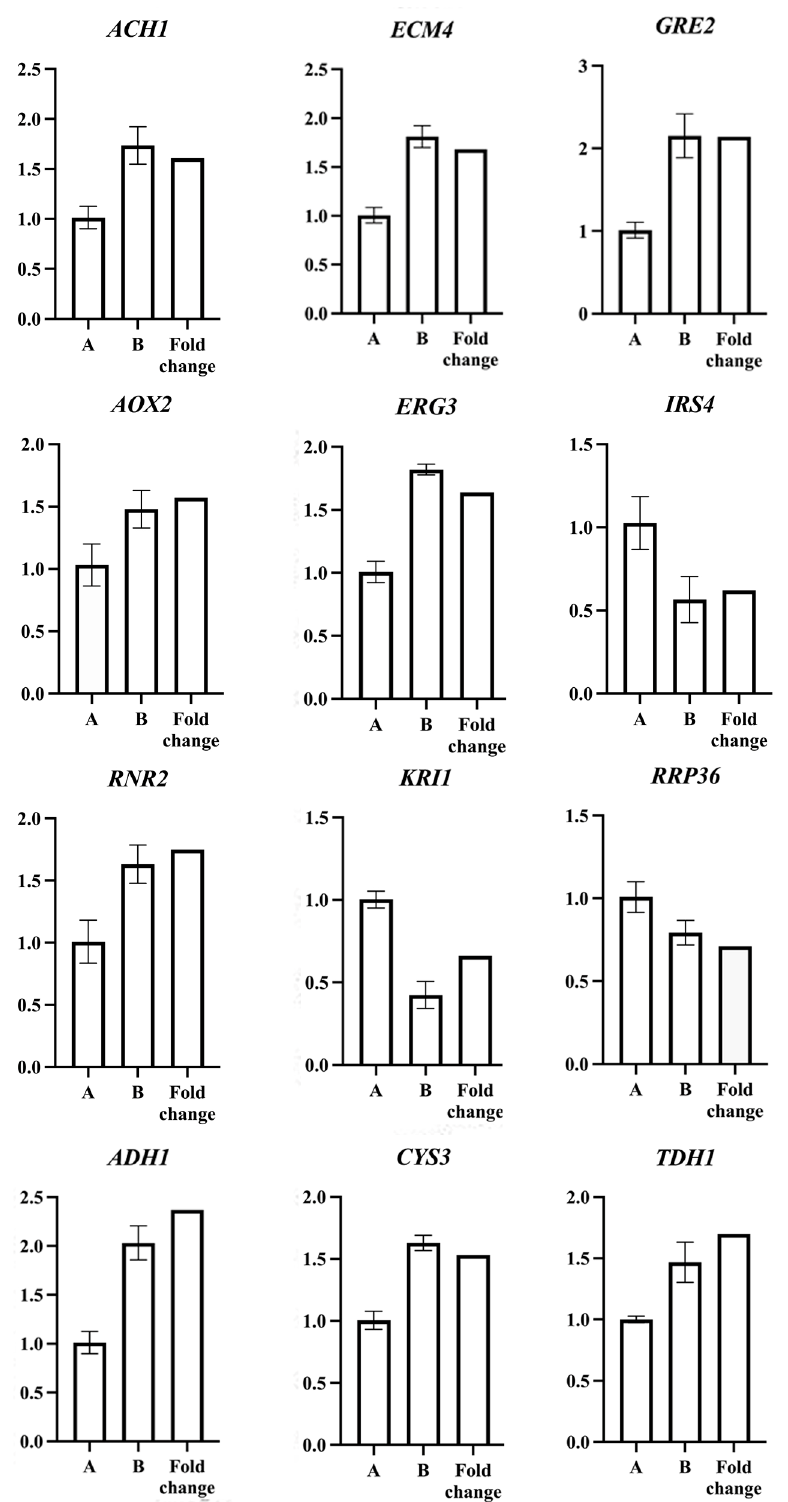
Figure 7. Results of verification of differently expressed genes by RT-qPCR. A: Relative gene expres- sion level of S. spartinae W9 cultured in NYDB. B: Relative gene expression level of S. spartinae W9 cultured in NYDB with 0.1% β -glucan. Fold Change: Transcriptome sequencing results. Bars repre- sent standard errors.